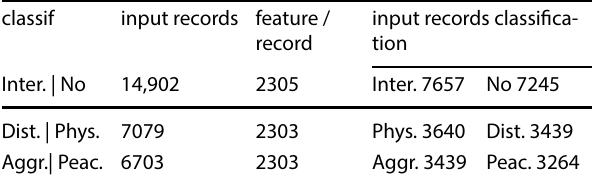
Table 4 Balanced dataset input characteristics classif